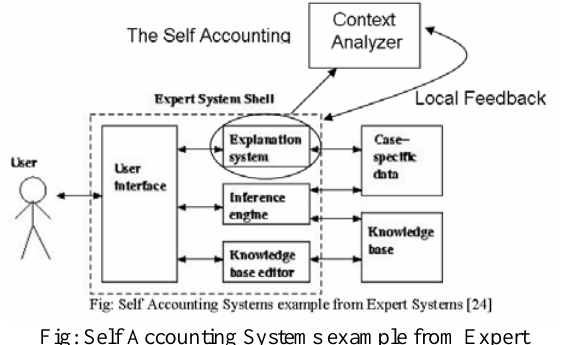
Fig: Self Accounting Systems example from Expert Systems